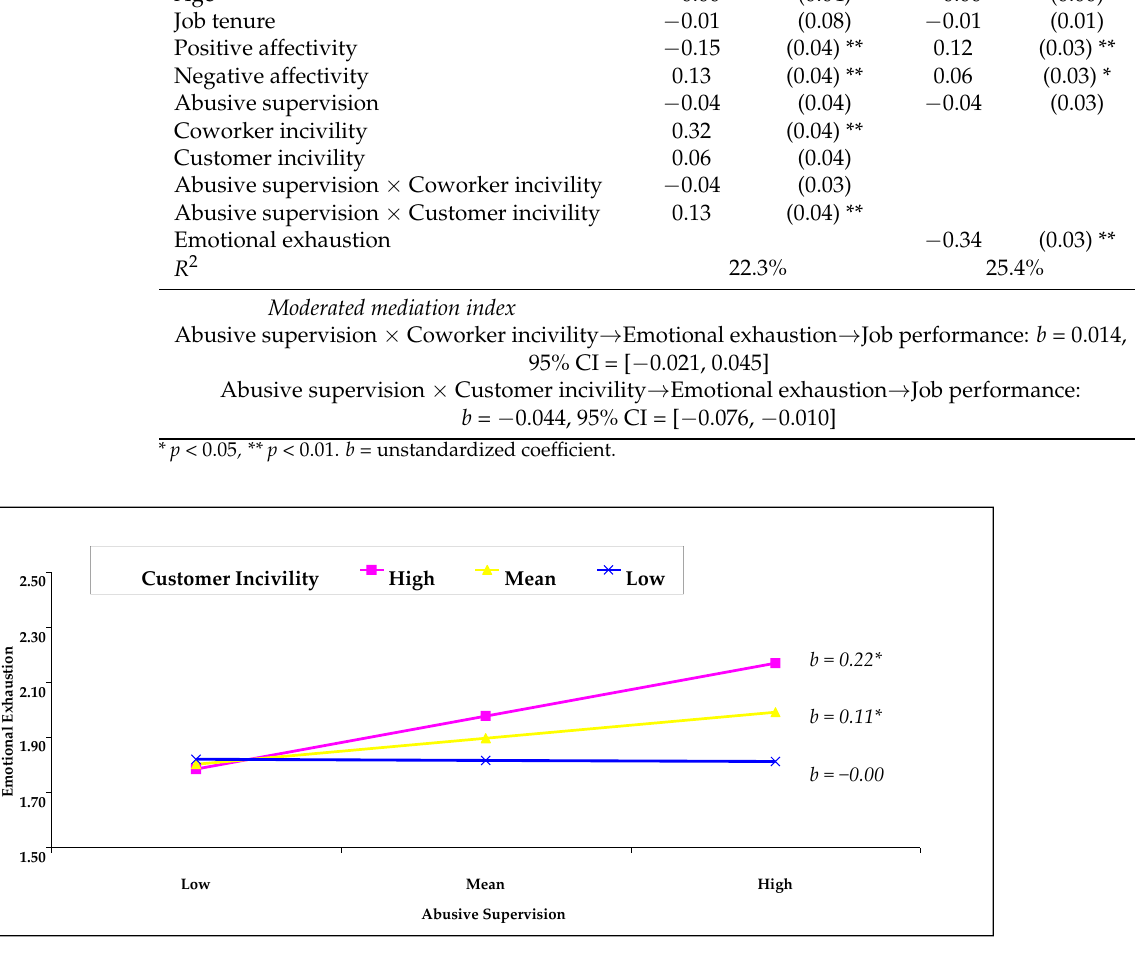
Figure 2. Simple plot analysis for the interaction effect of abusive supervision and coworker incivility on emotional ex- haustion. * p < 0.05. b = unstandardized coefficient.